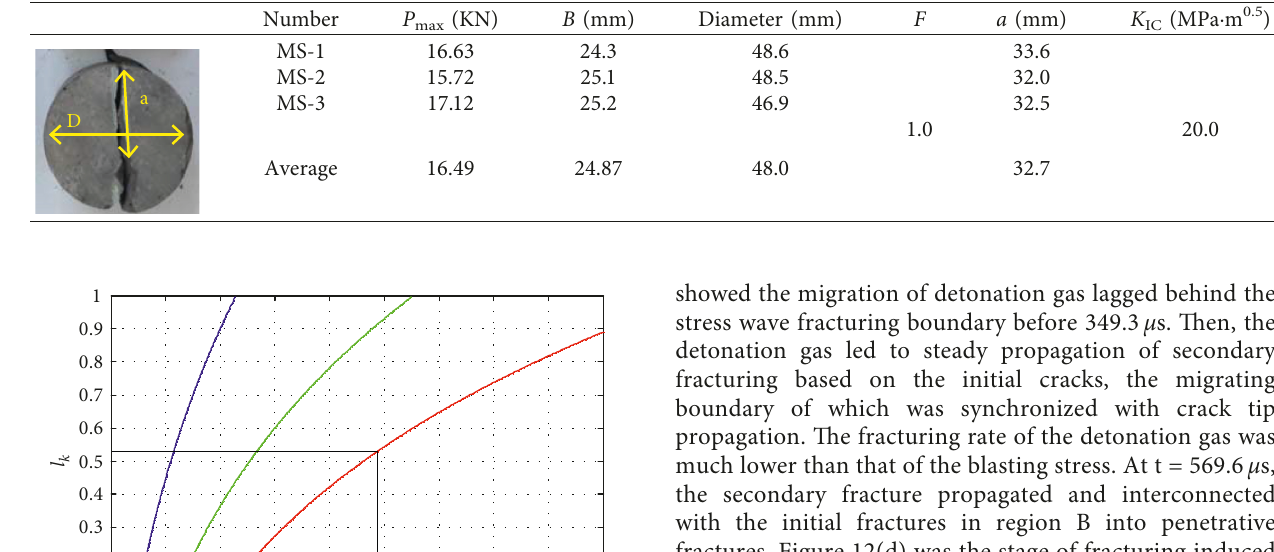
Table 3: Fracture parameters of